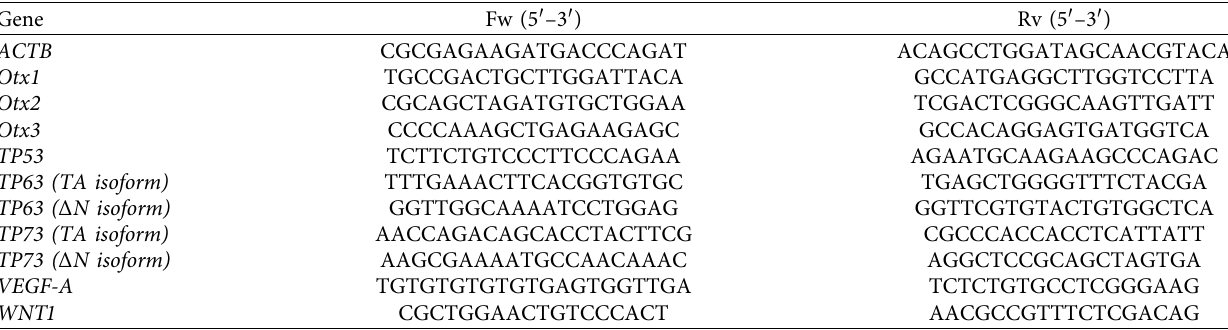
Table 2: List of primers used in qRT-PCR experiments. Each primer sequence is written from the 5 ′ end to the 3 ′ end.